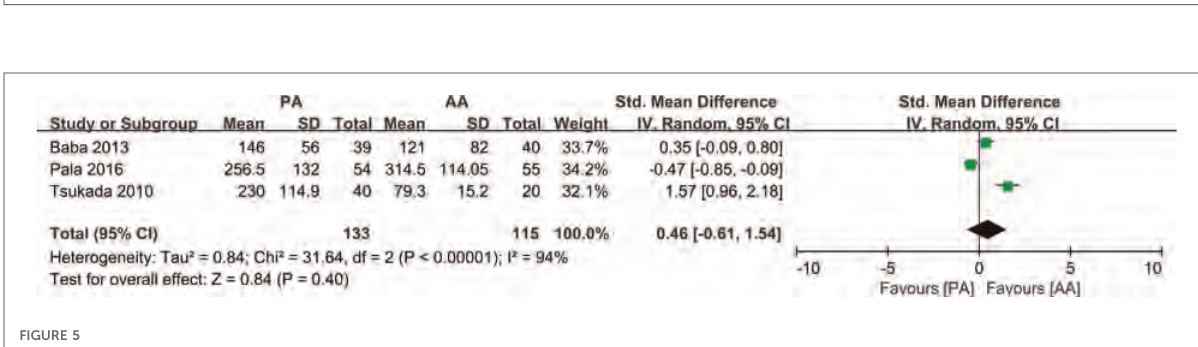
FIGURE 4 Forest plot comparison of operation time. ( A ) Anterior approach and lateral approach, ( B ) Posterior approach and lateral approach, ( C ) Posterior approach and anterior approach.